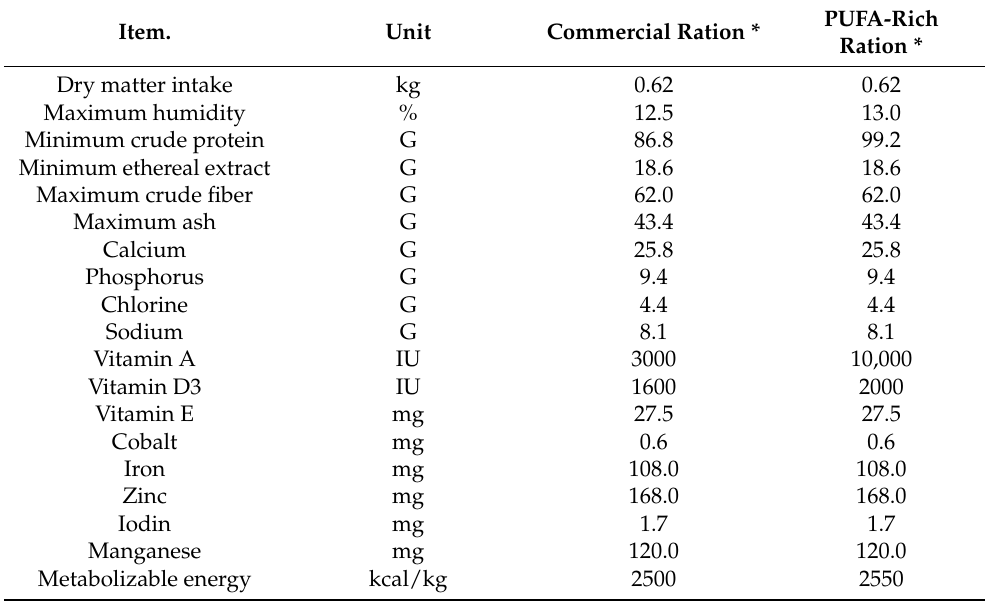
Table 1. Supplied food and chemical composition of the experimental concentrates fed during the trial. Item. Unit